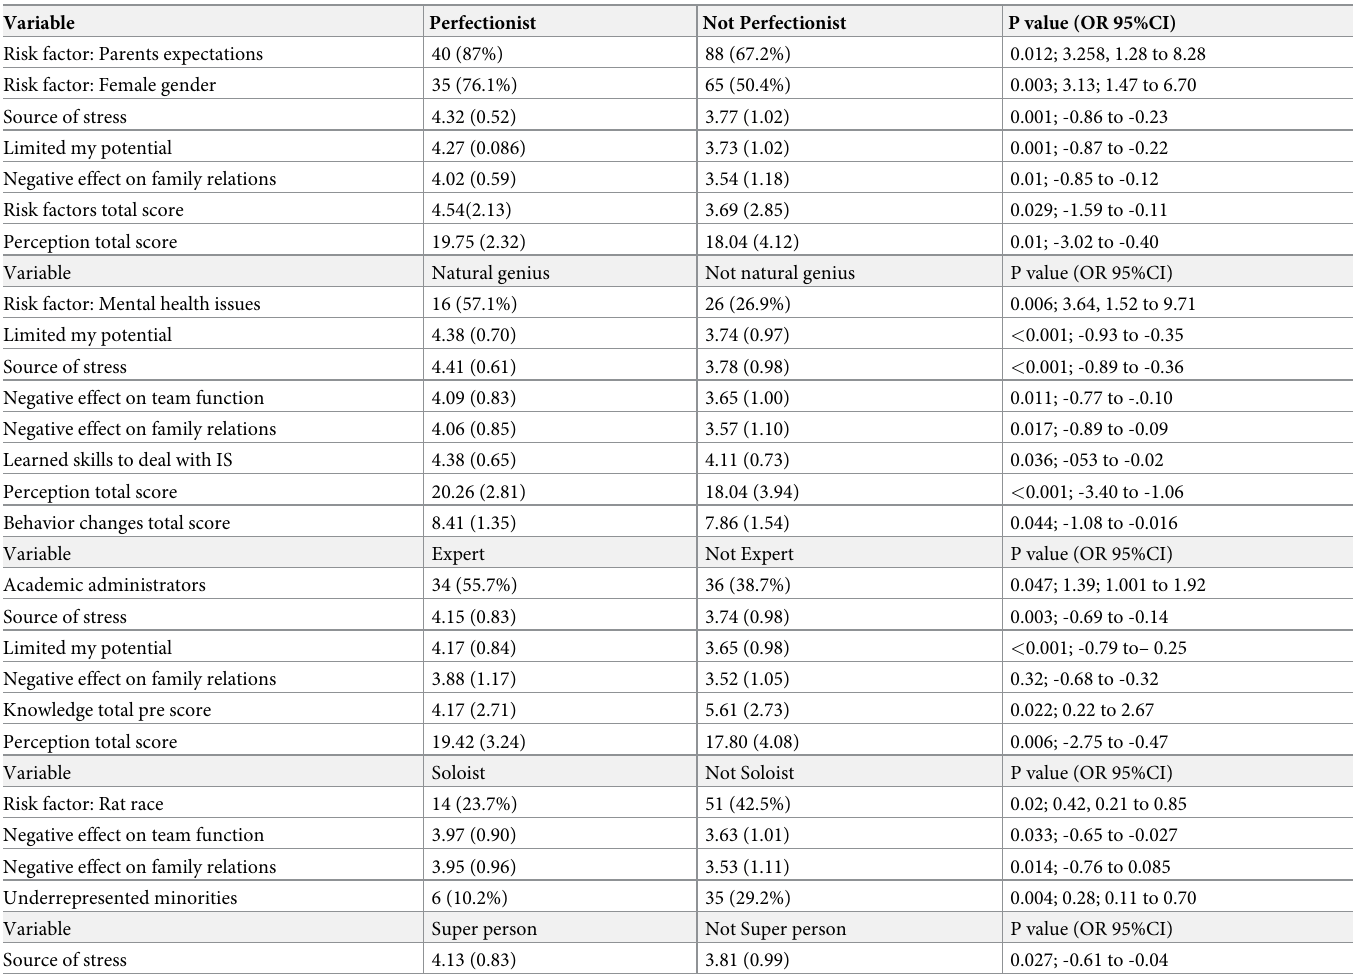
Table 4. Significant associations of the impostor syndrome competence